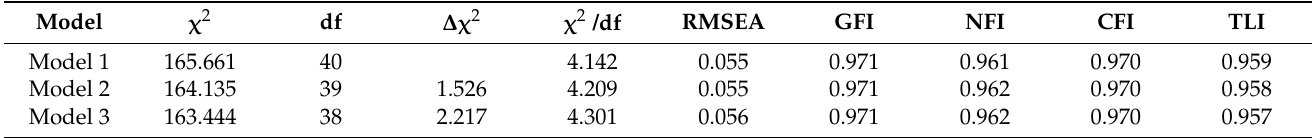
Table 3. Goodness-of-fit index.